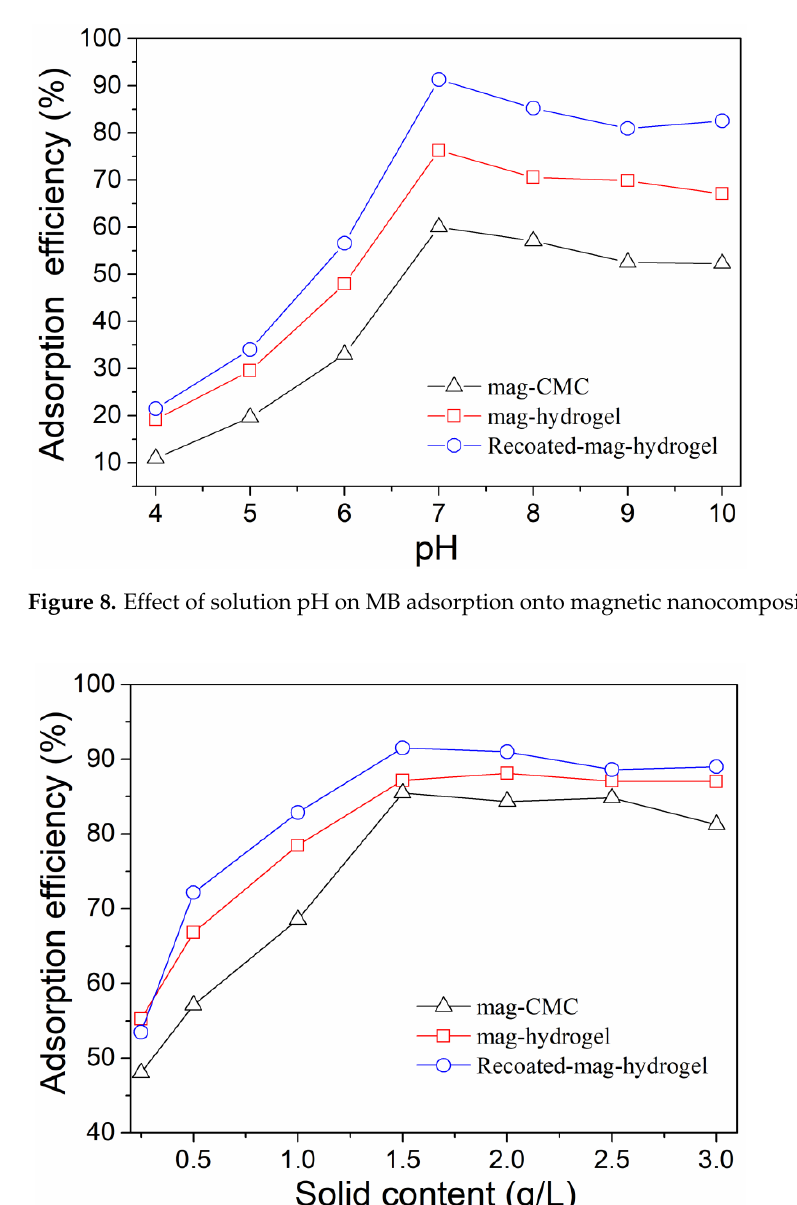
Figure 8. Effect of solution pH on MB adsorption onto magnetic nanocomposites.